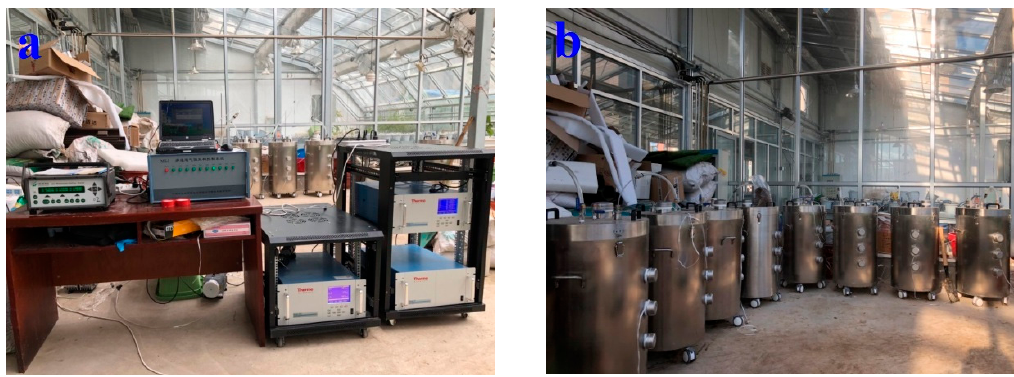
Figure 2. A photographical view of the experimental setup. ( a ) the instruments, ( b ) composting reactor.